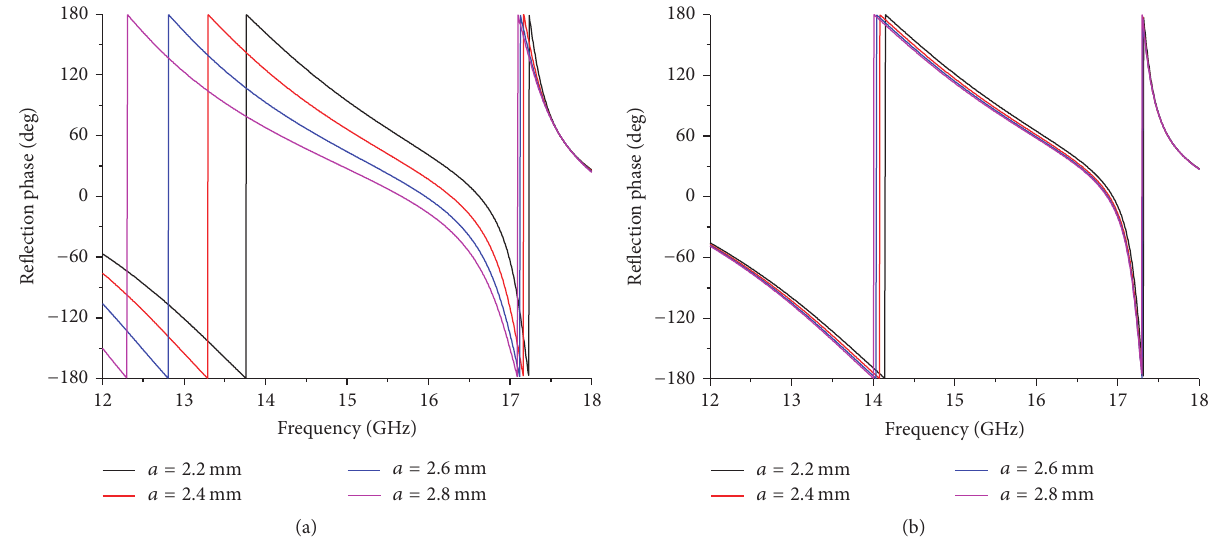
Figure 6: Reflection phase for various values of 𝑎 : (a) under major axis polarized incidence; (b) under minor axis polarized incidence.